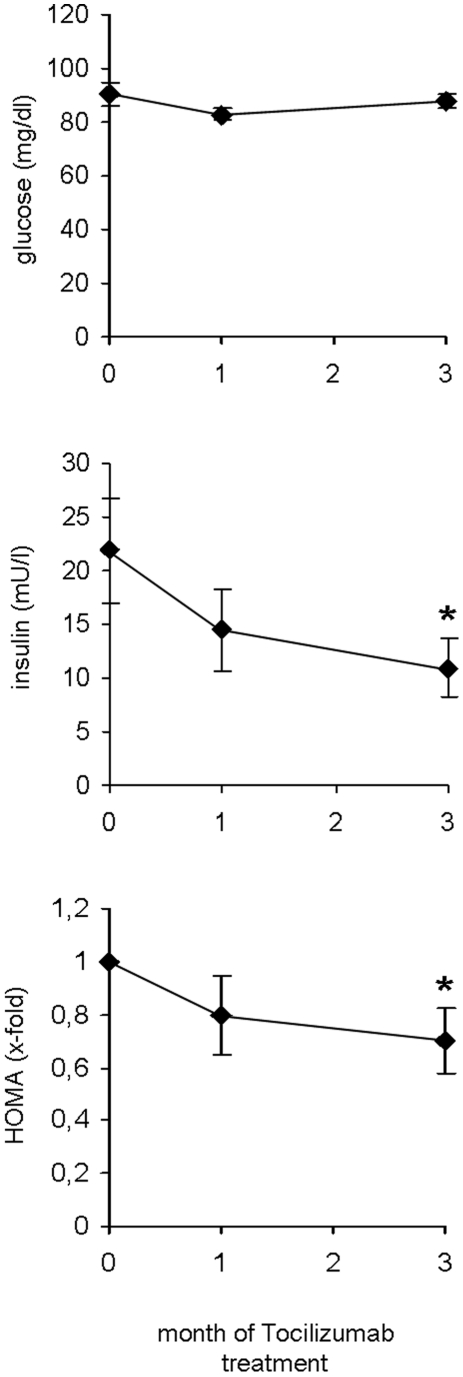
Effect of IL-6 inhibition on insulin sensitivity of human subject.Data are expressed as Means ± SEM. * = p<0.05.